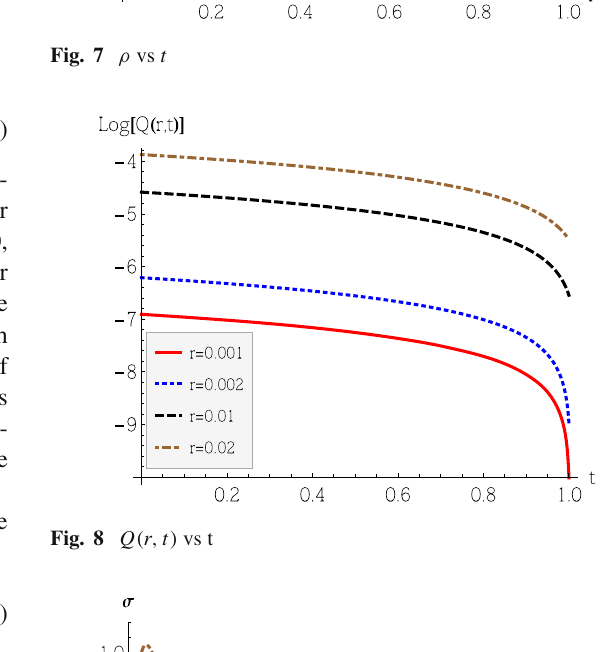
Fig. 8 Q ( r , t ) vs t